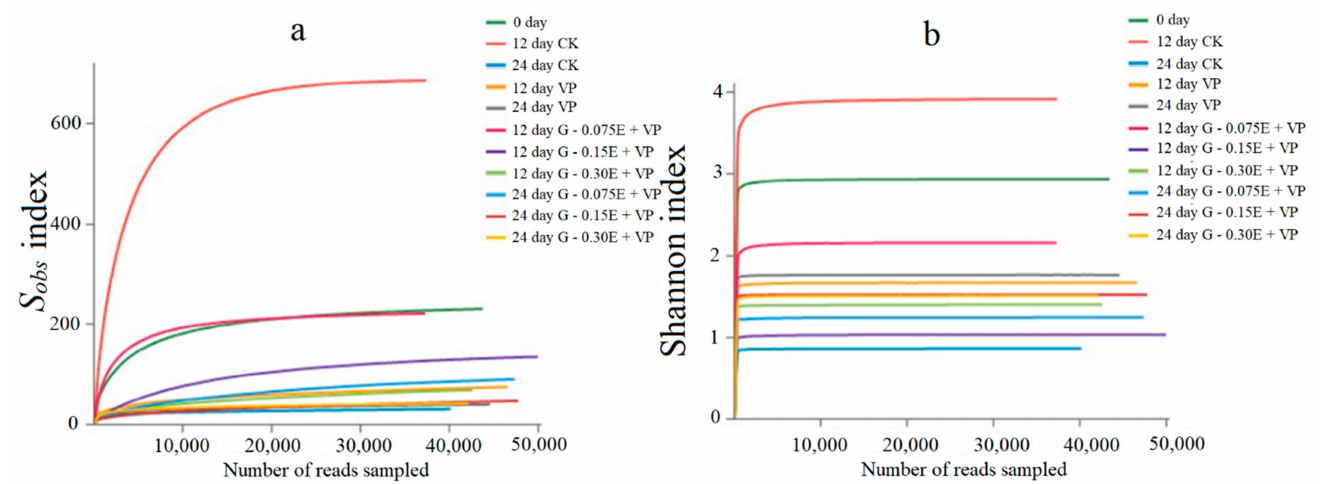
Figure 2. Rarefaction curve of each sample: ( a ) S obs index; ( b ) Shannon